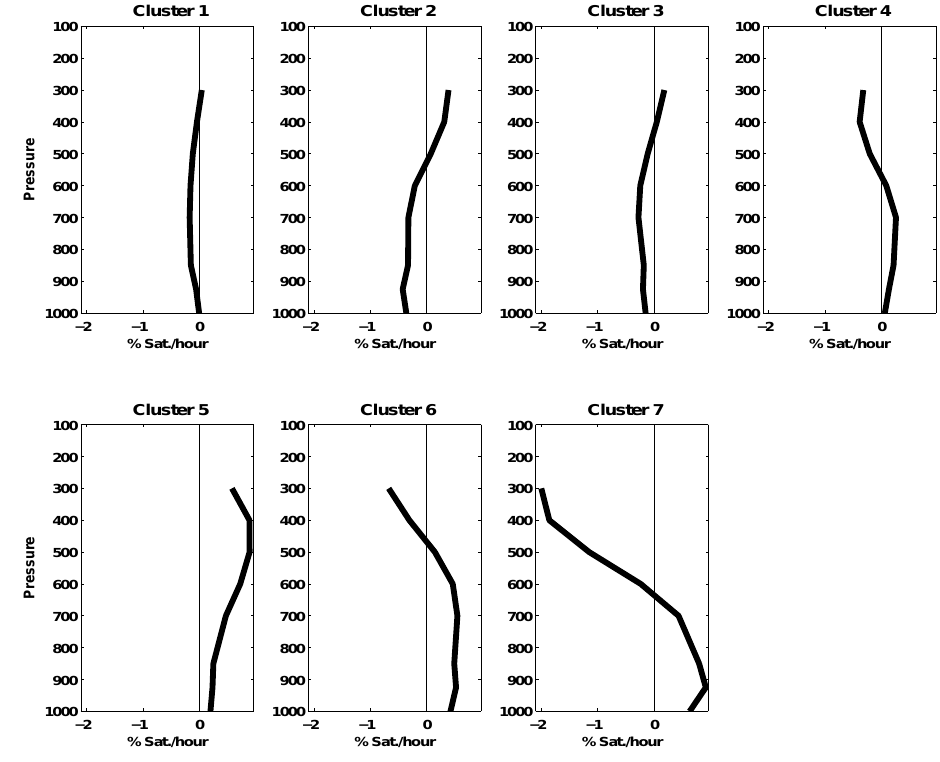
Fig. 5. As in Fig. 2, except for perturbation horizontal moisture